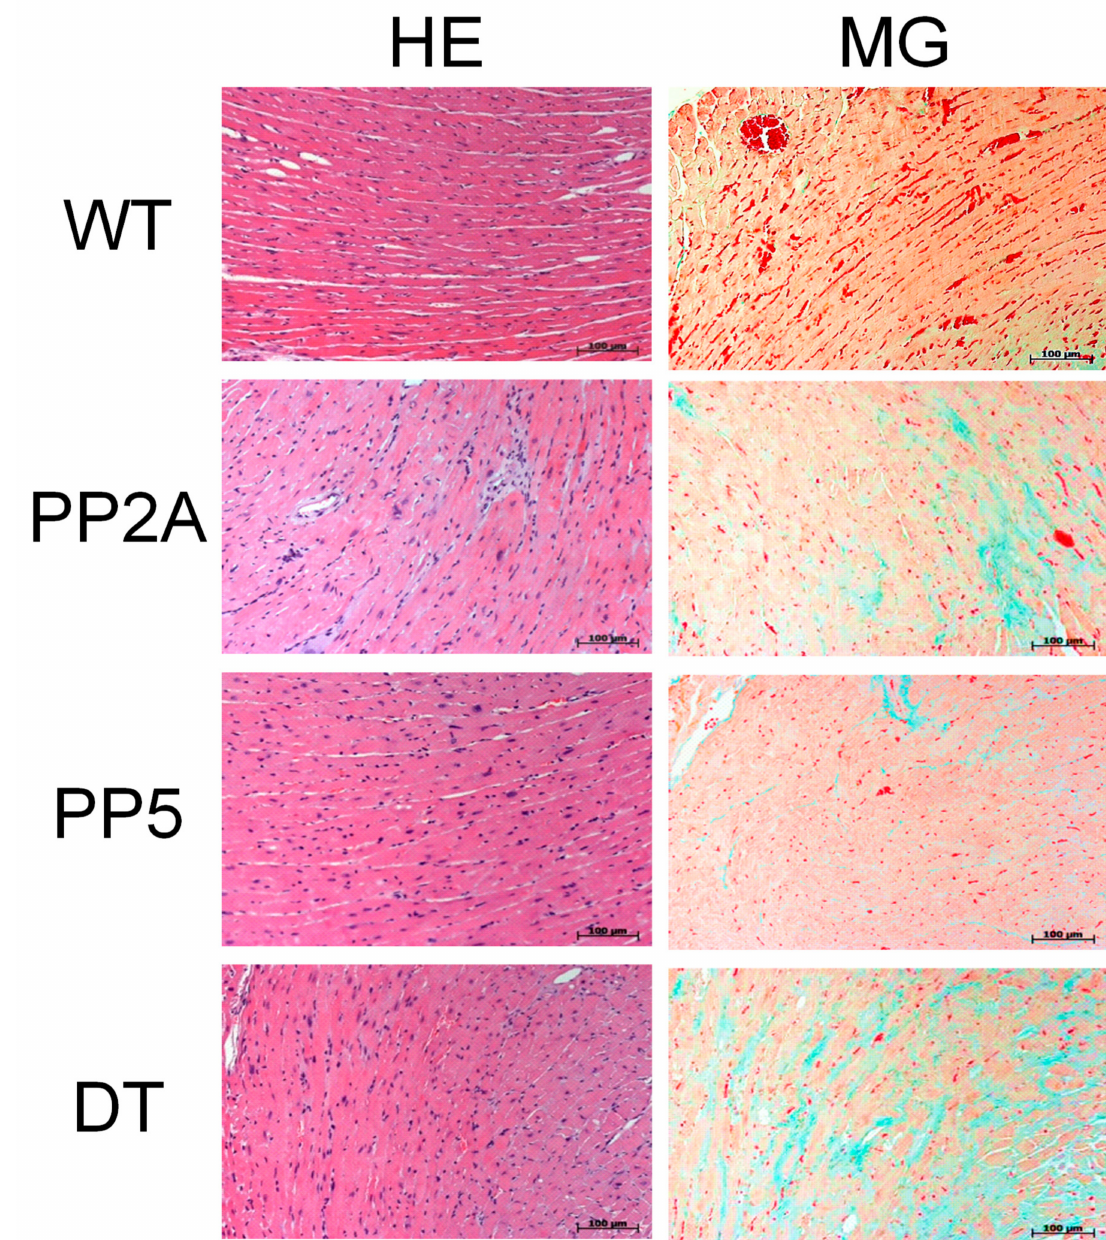
Figure 3. Hematoxylin-Eosin-staining (HE) and Masson-Goldner-trichrome-staining (MG) of heart slices from WT, PP2A, PP5 and DT mice of age group